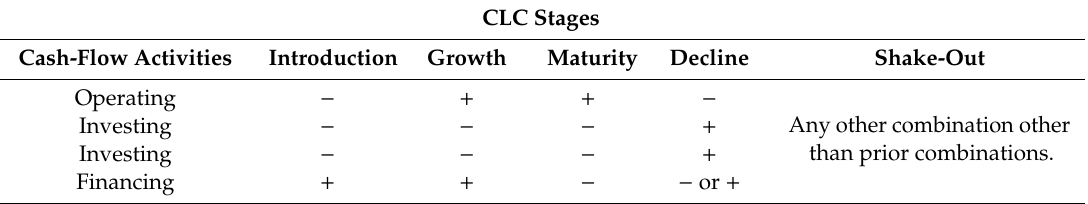
Table 1. Measurement of corporate life cycle stages using Dickinson (2011)